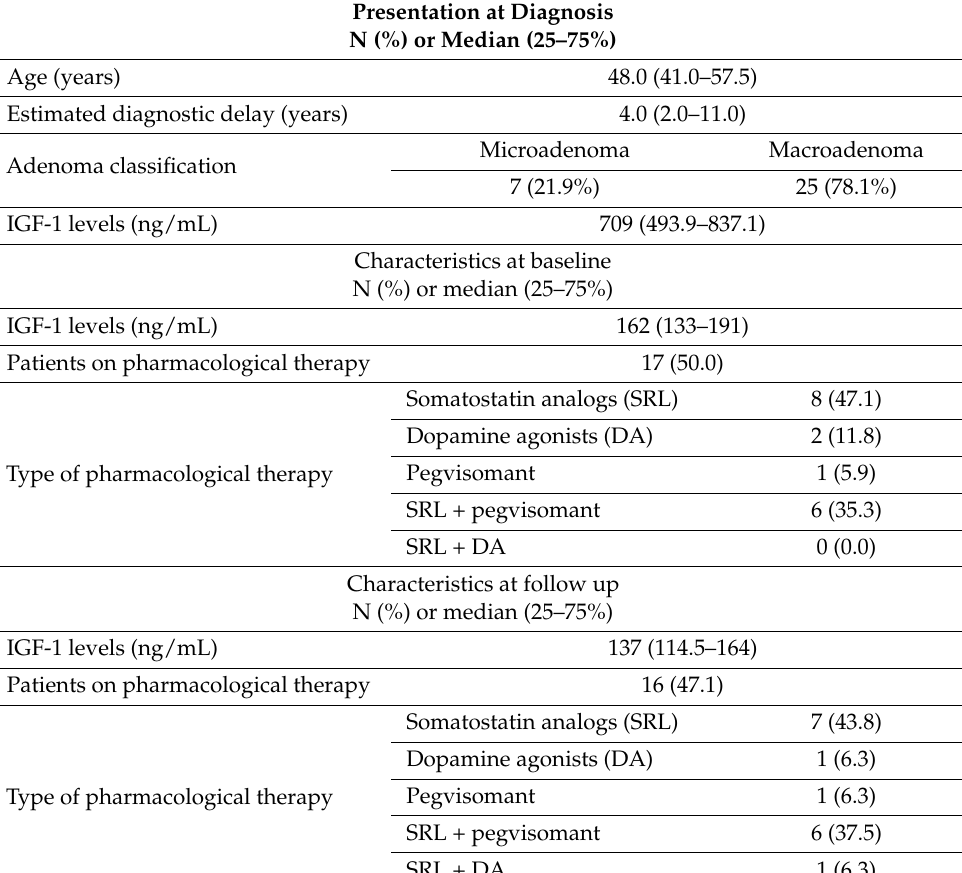
Table 1. Patients’ characteristics at the time of diagnosis, at baseline of the study and at the follow up. Presentation at